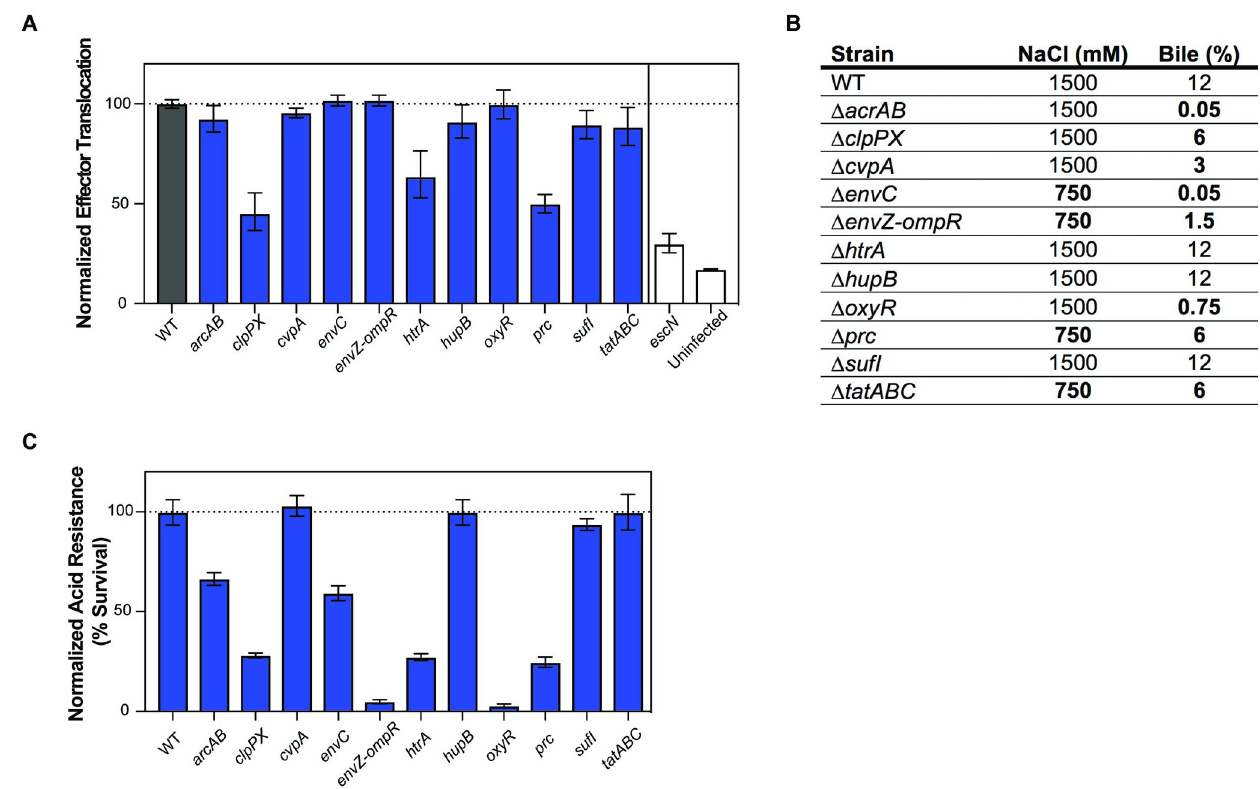
Fig 6. Effector translocation and survival in response to various gastro-intestinal stressors by mutants defective in colonization. (A) Normalized effector translocation of mutants compared to WT. Δ escN , a mutant that abrogates T3SS activity, was used as a control. Mutants were tested for their ability to translocate EspF-TEM1 into HeLa cells, as measured by a shift in emission spectra from 520 to 450 nm. Fluorescence was normalized to WT levels. Geometric means and geometric standard deviations are plotted. (B) MIC for NaCl (osmotic stress) and crude bile for the indicated mutants. Bold text highlights values differing from the wild-type. (C) Normalized acid resistance. Mutants were tested for their ability to survive low acid shock. Survival is shown as a percentage of the acid resistance of the WT. Geometric mean and geometric standard deviation are plotted.